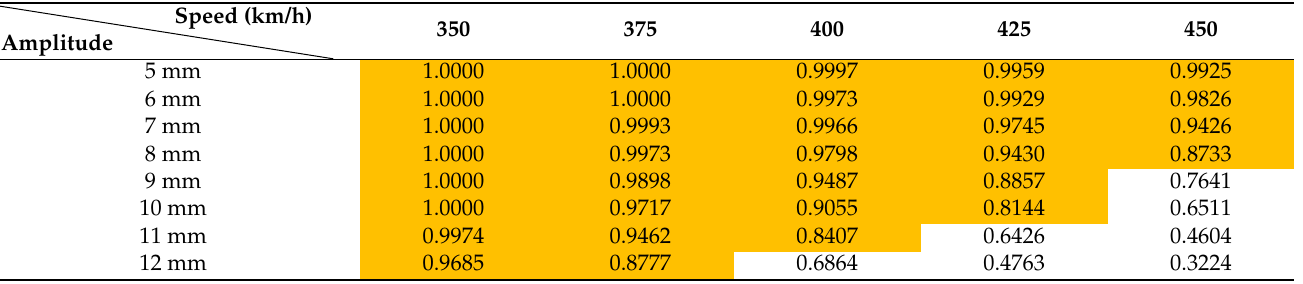
Table 2. Reliability of vehicle vertical safety at 350 km/h and above without considering stochastic vehicle parameters.